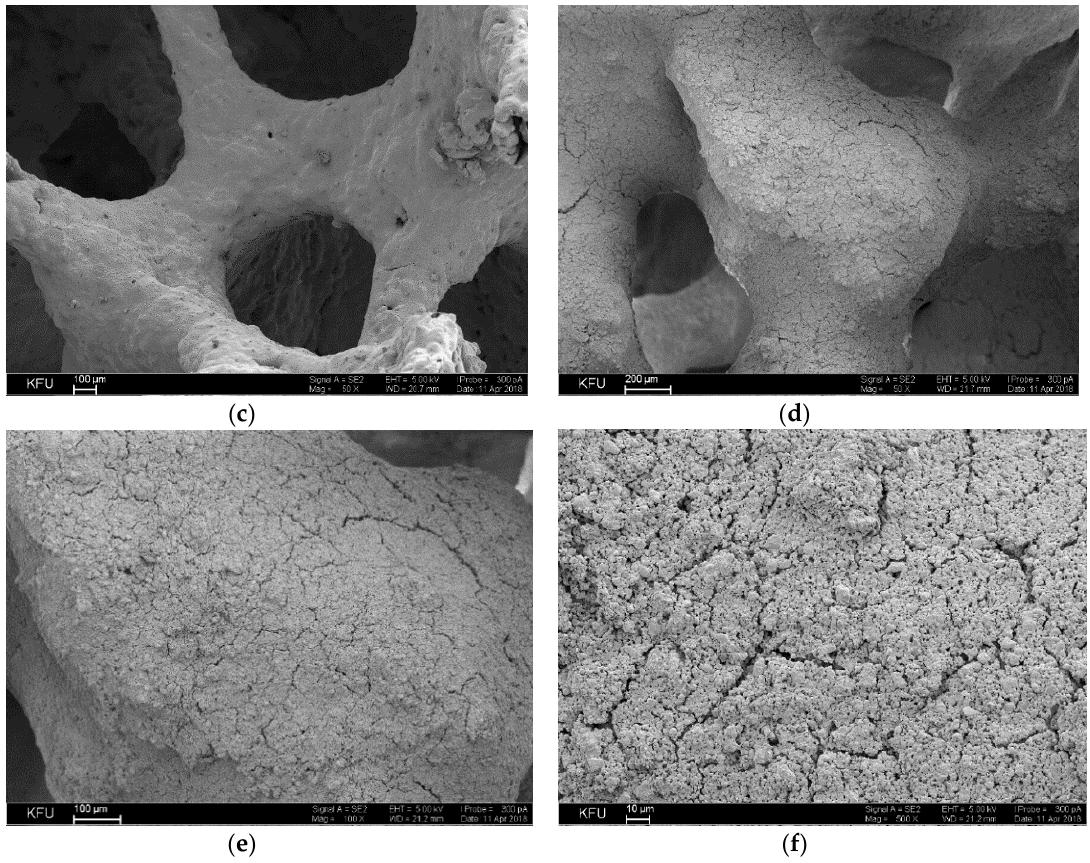
Figure 6. ( a,b ) Images of highly porous α -Al 2 O 3 -HPCM support; ( c ) SEM image of highly porous support surface; ( d–f ) SEM images of highly porous catalyst.